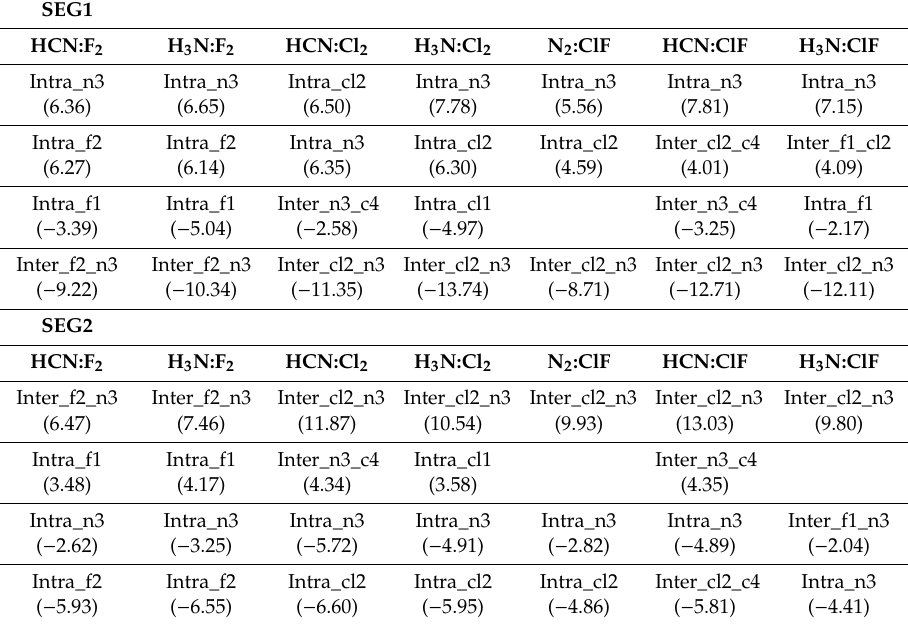
Table 4. REG analysis of the total interatomic, V AB , and intra-atomic energies, E A (Level 2). For each inter intra complex, the largest two energies are listed (most positive and most negative REG value by absolute value except if smaller than 2.0). The REG values are shown in parentheses. The atomic labeling follows X 1 –X 2 ··· N 3 - etc. where X = Cl or F, and the numeric labels of atoms not marked in this core common scheme increase while moving away from X inner